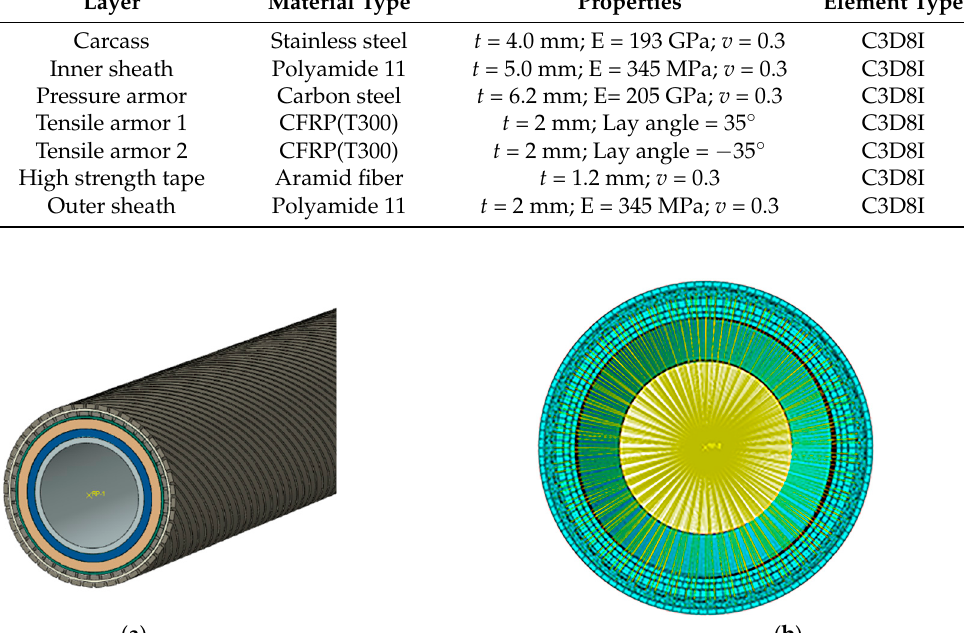
Figure 11. ( a ) FE model of unbonded 4-inch flexible riser; ( b ) pipe end coupling